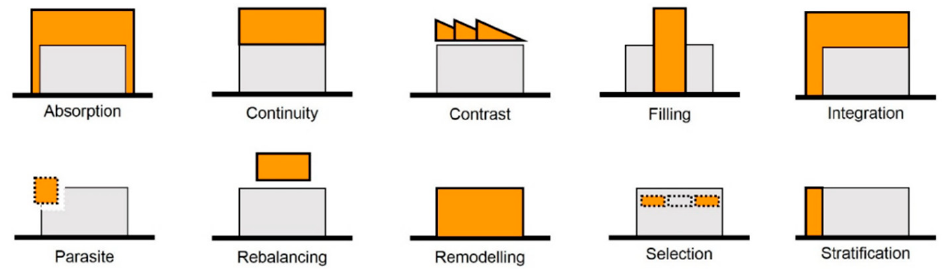
Figure 3. Strategies of interventions on residential heritage.